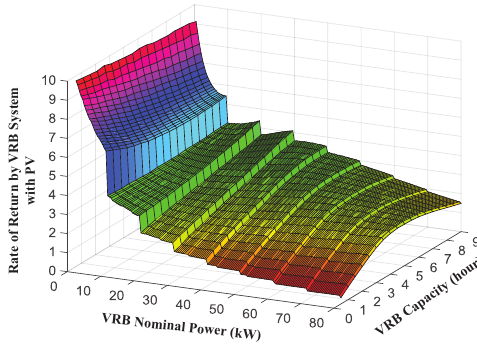
Figure 10. Rate of return (ratio between the net benefit and investment cost) of the VRB system with PV.